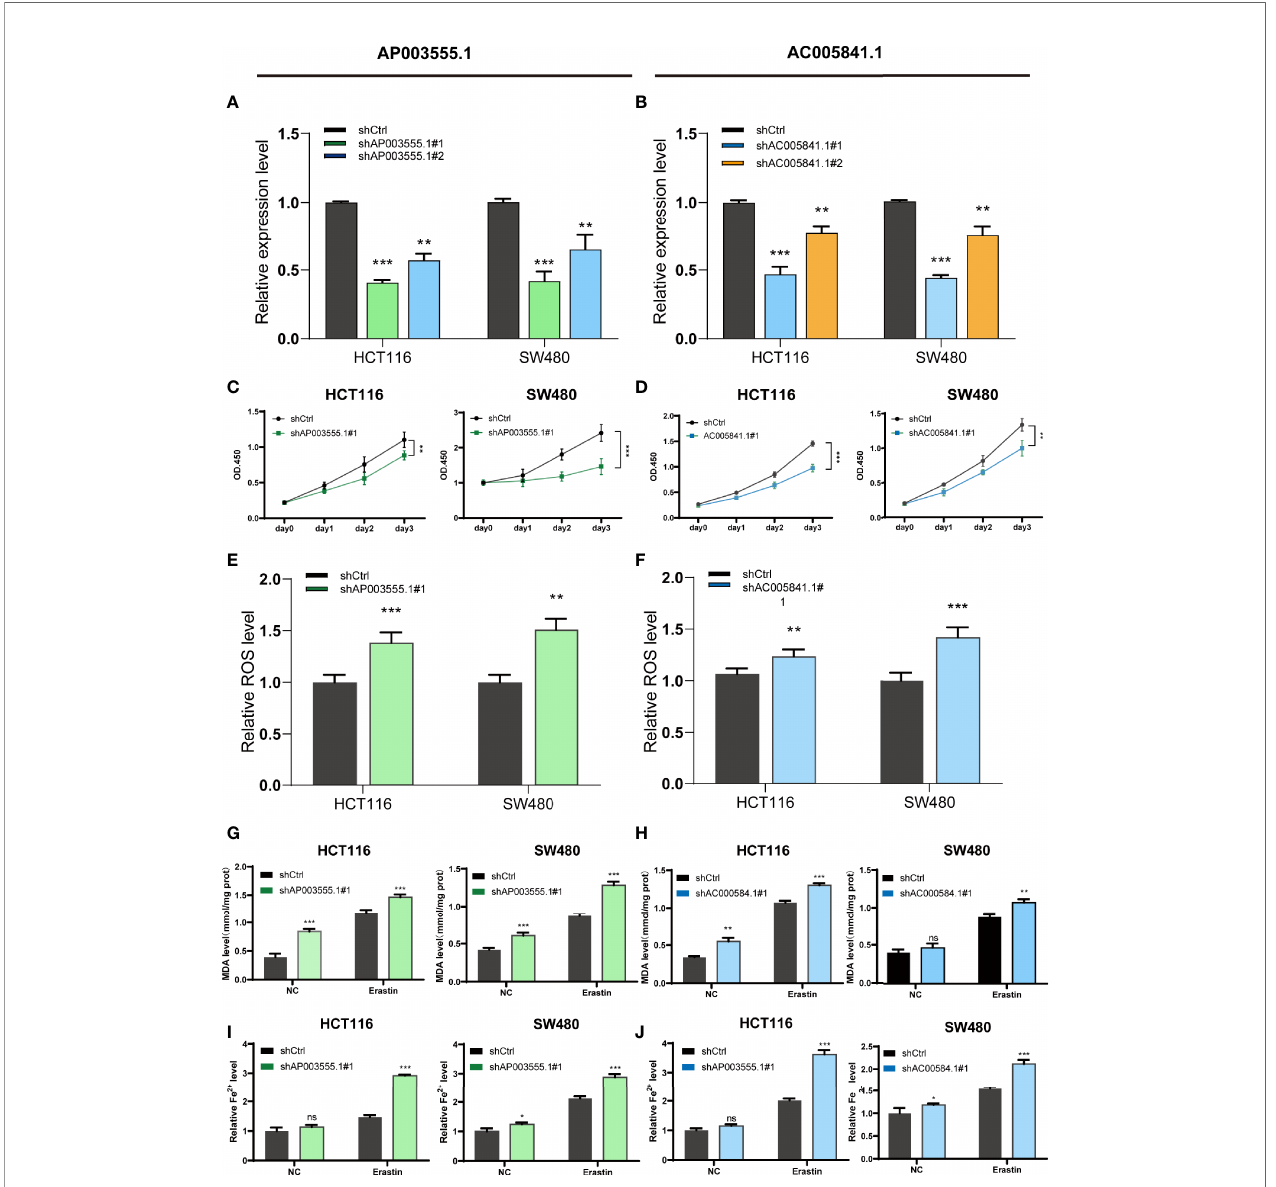
FIGURE 10 | Ferroptosis regulation of AP003555.1 and AC005841.1. (A,B) Relative expression level ofAP003555.1 and AC005841.1 after transfection with the corresponding shRNA. (C) The cellproliferation ability of HT116 andSW480 cells after the knockdown of AP003555.1. (D) The cell proliferation ability of HT116 andSW480 cells after the knockdownof AC005841.1. (E, F) The comparison of erastin-induced ROS in the treatment and control groups. (G – J) The ferroptosis process was evaluated bydetecting MDA and Fe2+ levels inthe non-erastin-induced anderastin-induced groups. *p < 0.05, **p < 0.01, and ***p < 0.001, ns, No signi fi